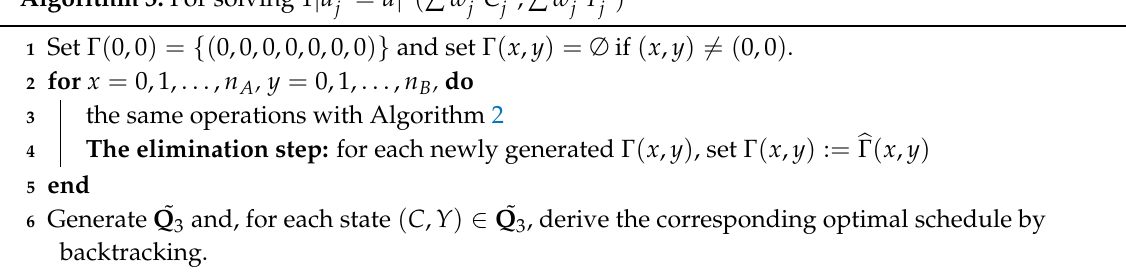
Algorithm 3: For solving 1 | d B